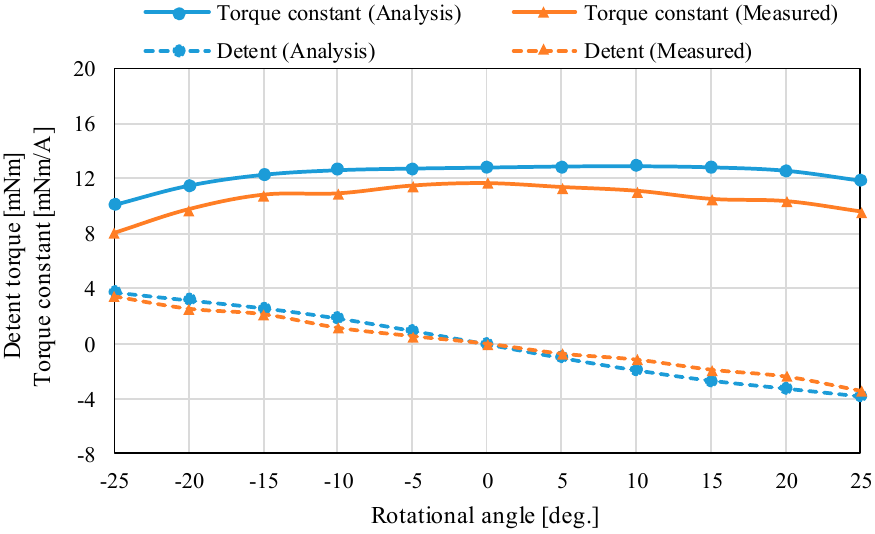
Figure 14. Torque characteristics in the X -axis.